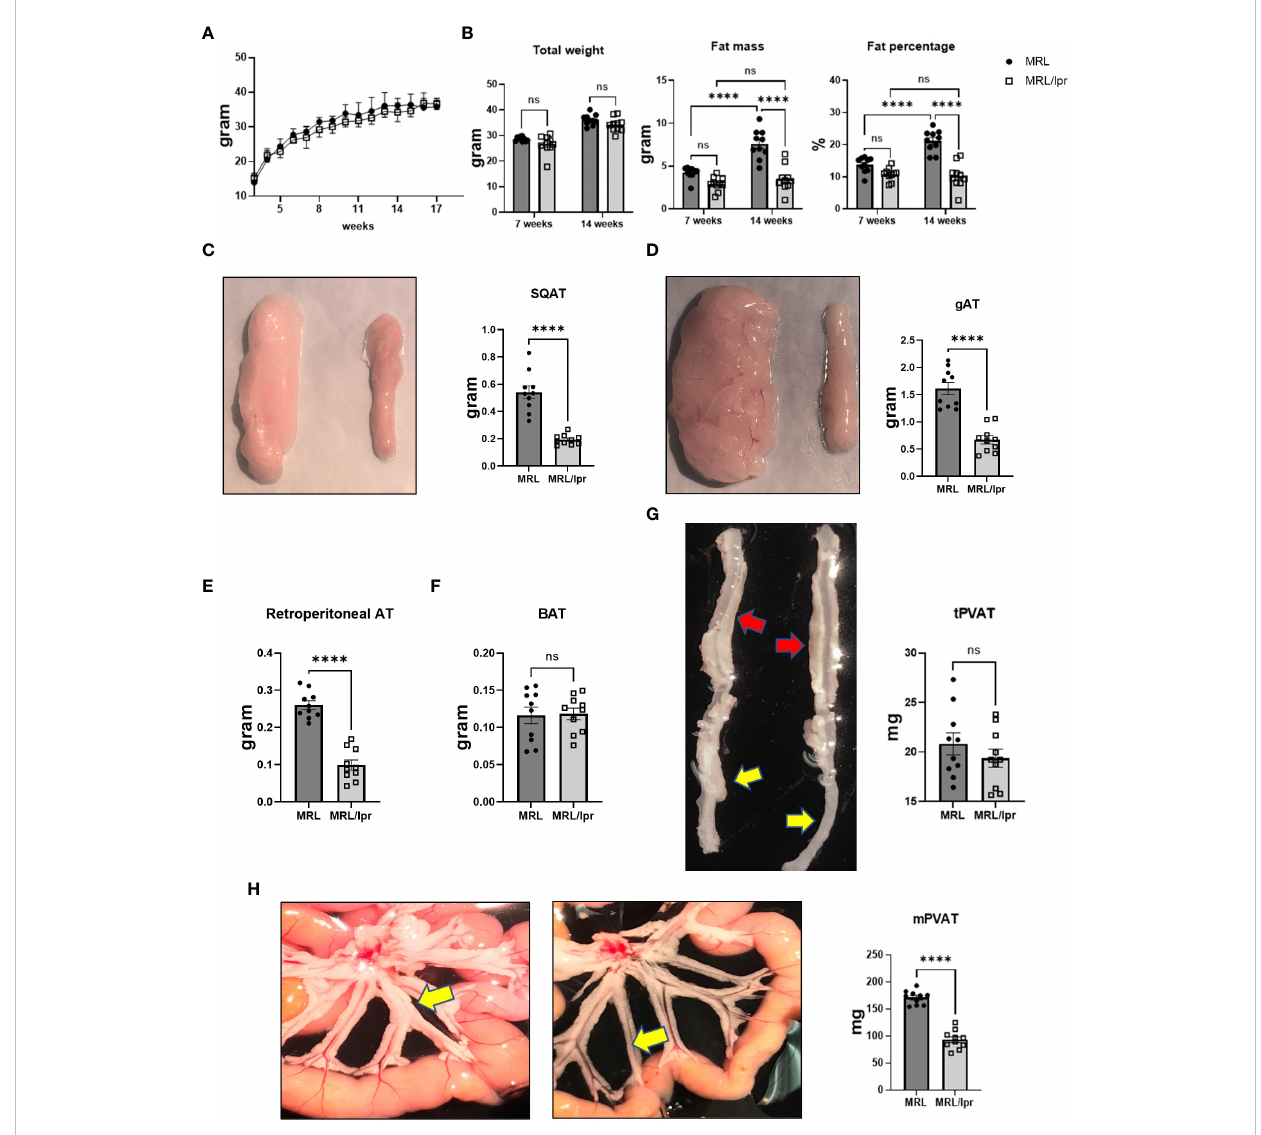
FIGURE 1 MRL/lpr mice with active disease exhibited partial lipodystrophy. (A) Body weights were monitored weekly. (B) Total weight, fat mass and fat percentage at baseline (7 weeks) and with active disease (14 weeks) measured by NMR. (C-G) Representative images and weights of adipose tissue depots. Subcutaneous (SQAT, (C) , gonadal (gAT, (D) , retroperitoneal (E) , brown (BAT, (F) , thoracic aortic PVAT (tPVAT, red arrows, (G) and abdominal aortic PVAT (aPVAT, yellow arrows, (G) and mesenteric arterial PVAT (mPVAT, yellow arrows, (H) . In all images, MRL tissues are depicted on the left and MRL/lpr on the right. n=10-15. ****p<0.0001 vs MRL (control). ns, not signi fi